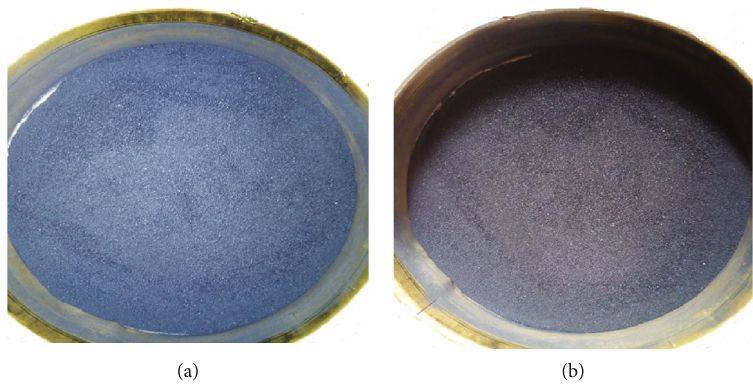
Figure 1: Synthesized activated carbons (a) RH-AC and (b)